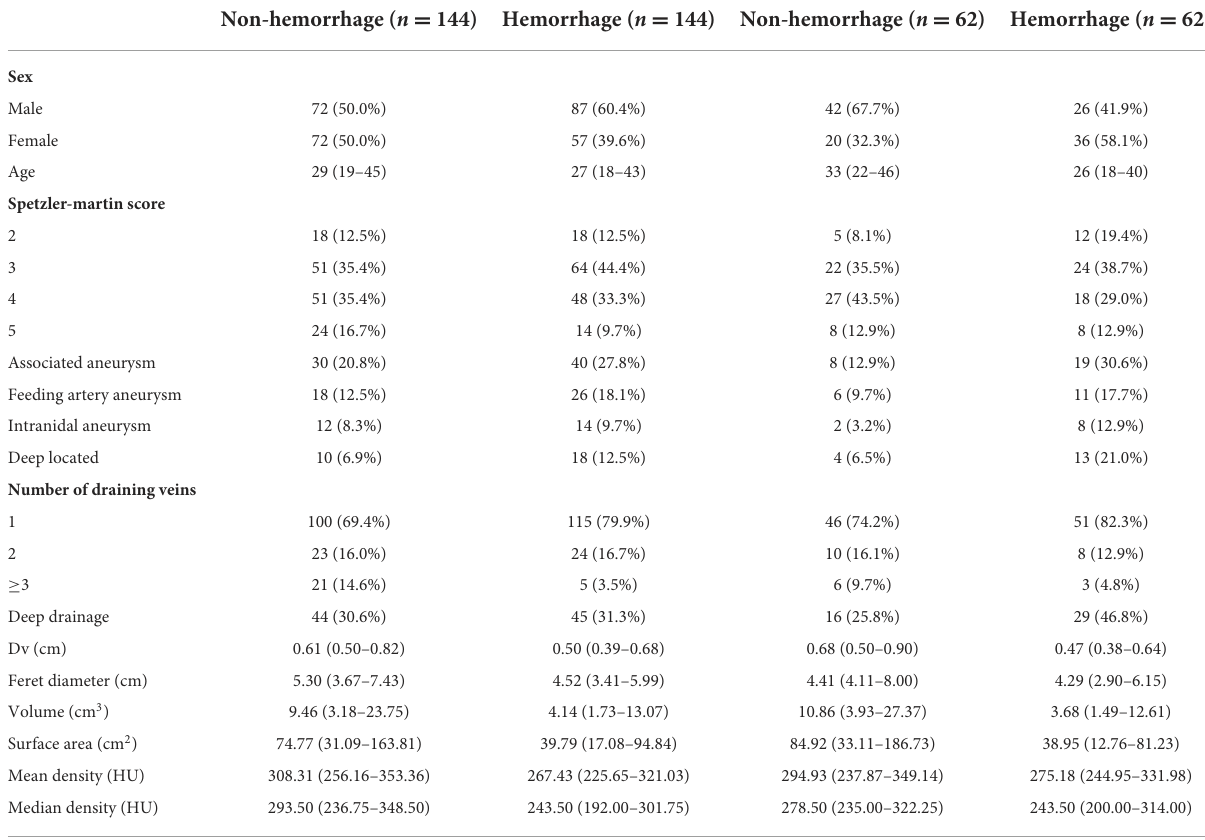
TABLE 4 The features of the training set and testing set. Training set Testing